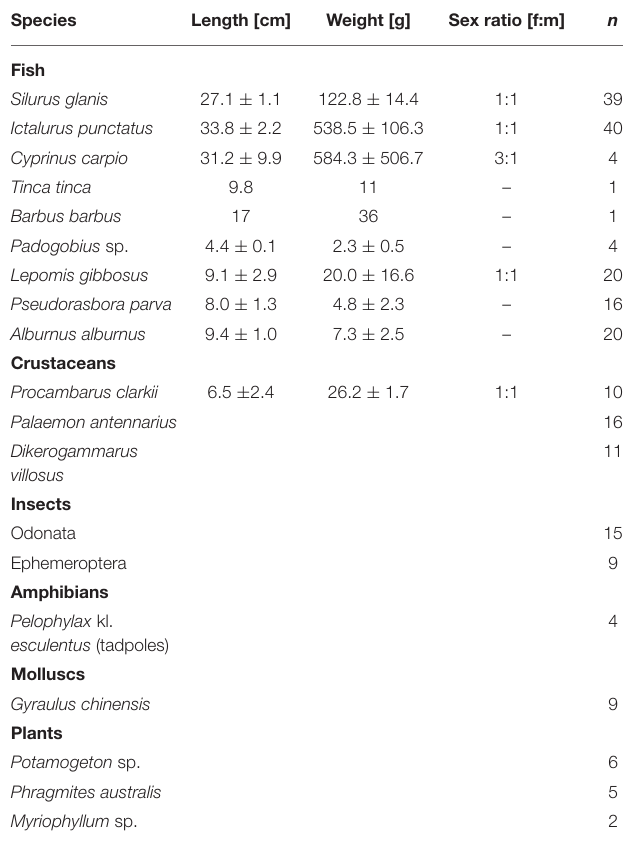
TABLE 2 | Morphological measures (mean ± SE), sex ratio (calculated as ratio of females, f. on males, m) and number of all sampled specimens. Length measured as total length (TL) for fishes and as cephalothorax length (CTL) for crayfish; n = number of specimens